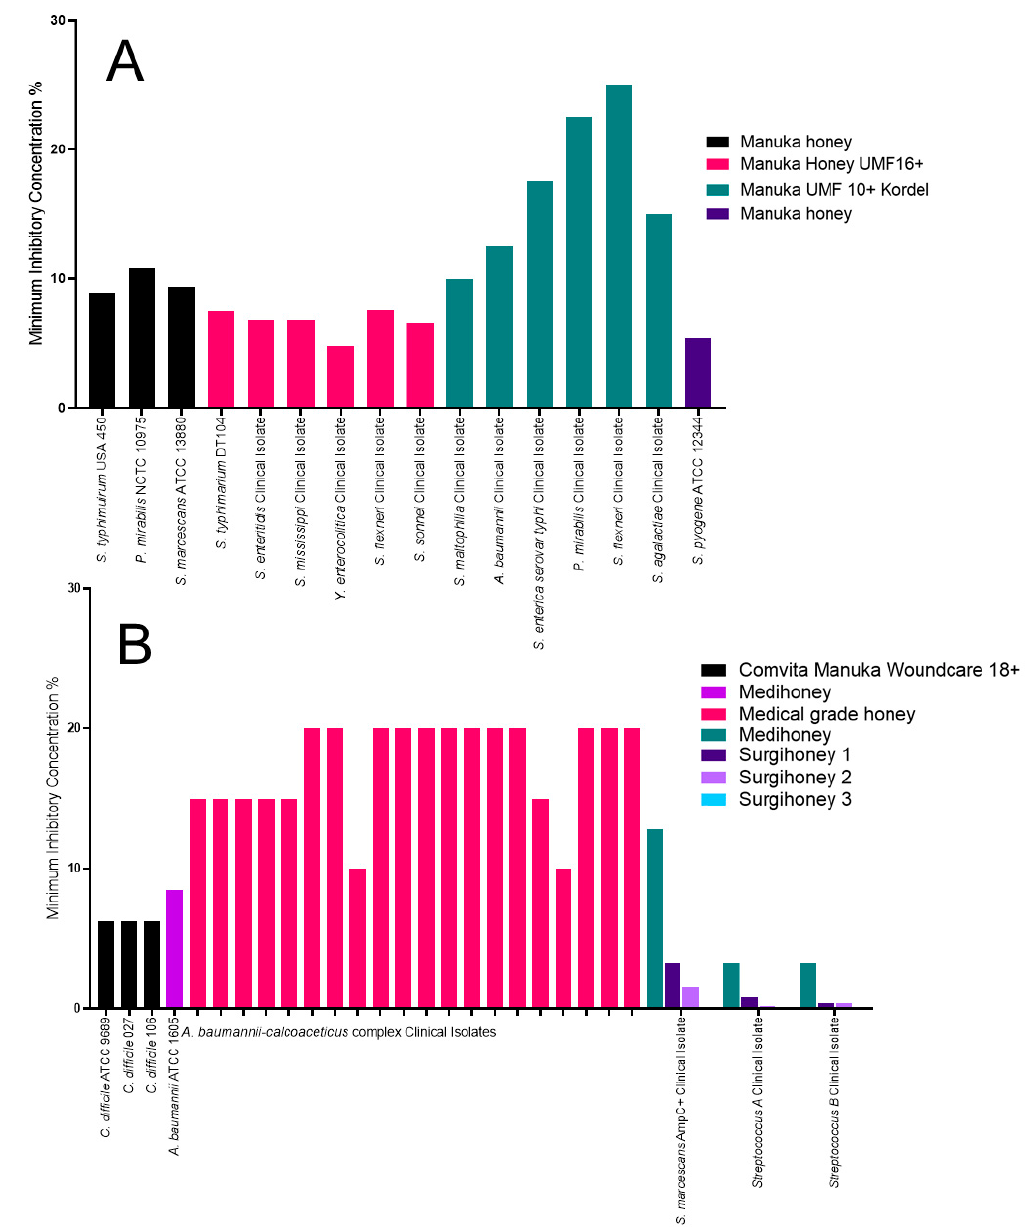
Figure 7. MICs of all other isolates tested against a variety of Manuka and medical-grade honey. ( A ) All the Manuka honey MIC data used in this review, identifying the ungraded Manuka honey and Manuka honey UMF16+ as the most effective; and ( B ) all the medical-grade honey MIC data used in this review, identifying a range of effectiveness between the honeys.